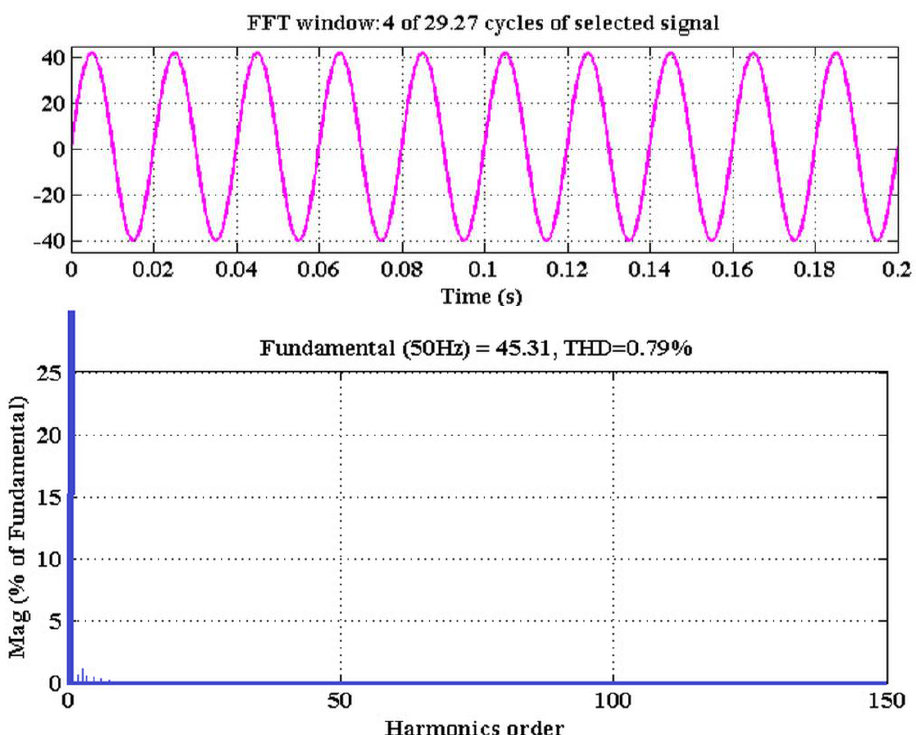
Figure 16. Grid current analysis and its harmonics spectrum.